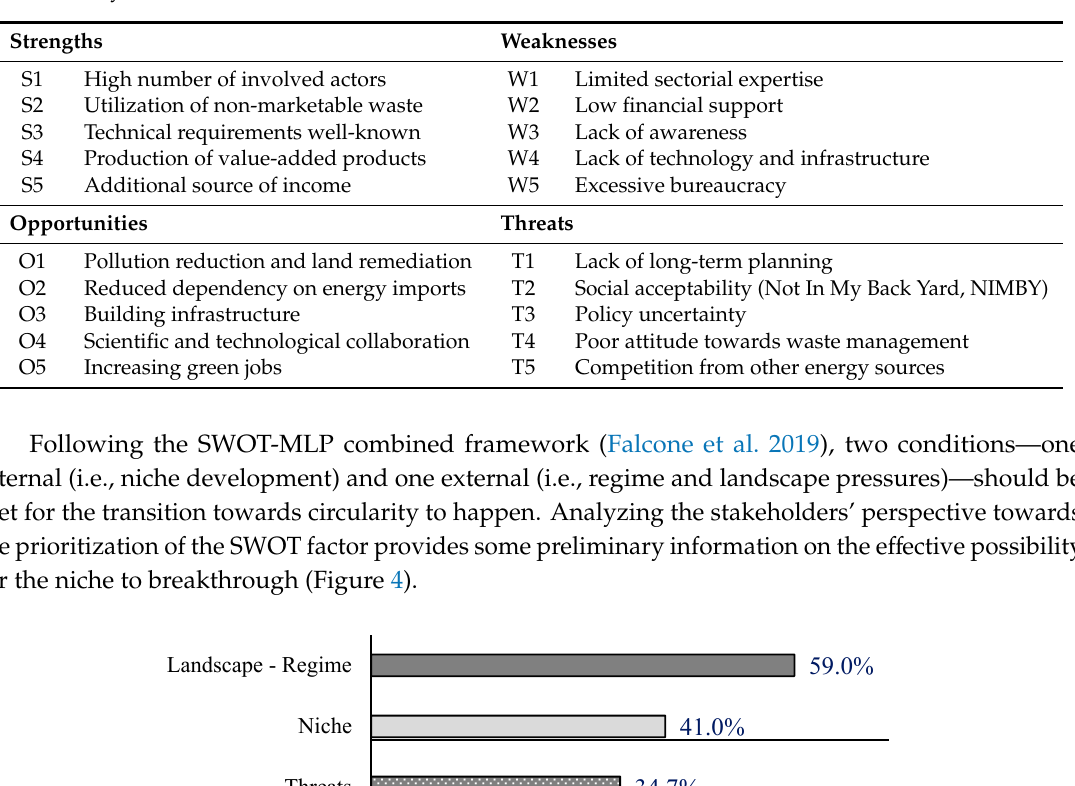
Table 6. The global priorities for SWOT factors determined through Strengths, Weaknesses, Opportunities and Threats – Analytic Network Process (SWOT-ANP).